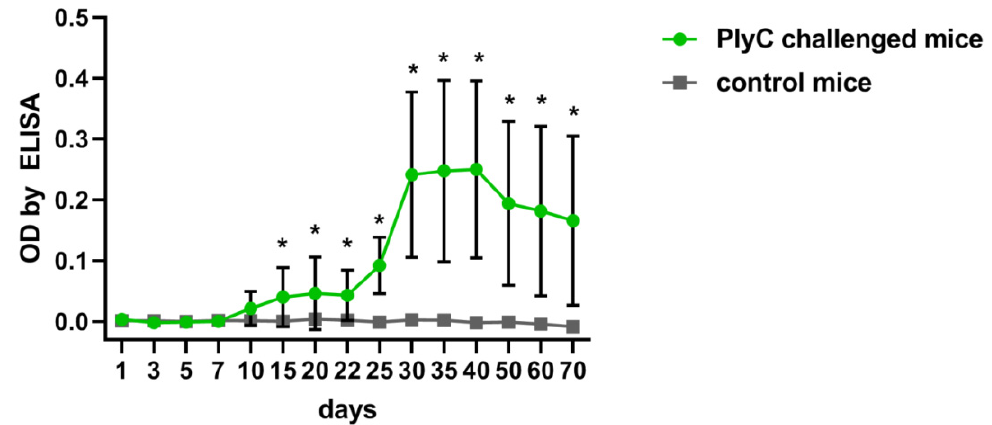
Figure 1. Induction of PlyC-specific IgG antibodies in mice over time. Mice were injected intraperitoneally with PlyC in PBS (100 µg/mouse in 0.2 mL) on day 0 and day 21, and control mice were at the same time injected intraperitoneally with PBS (0.2 mL); serum samples were collected and tested against PlyC by ELISA on indicated days. PlyC-challenged mice were compared to control mice at the same day ( n = 6). Mean values ± SD are given. *, adj. p < 0.05 (Welsch’s t-test). One of two technical replicates is presented.